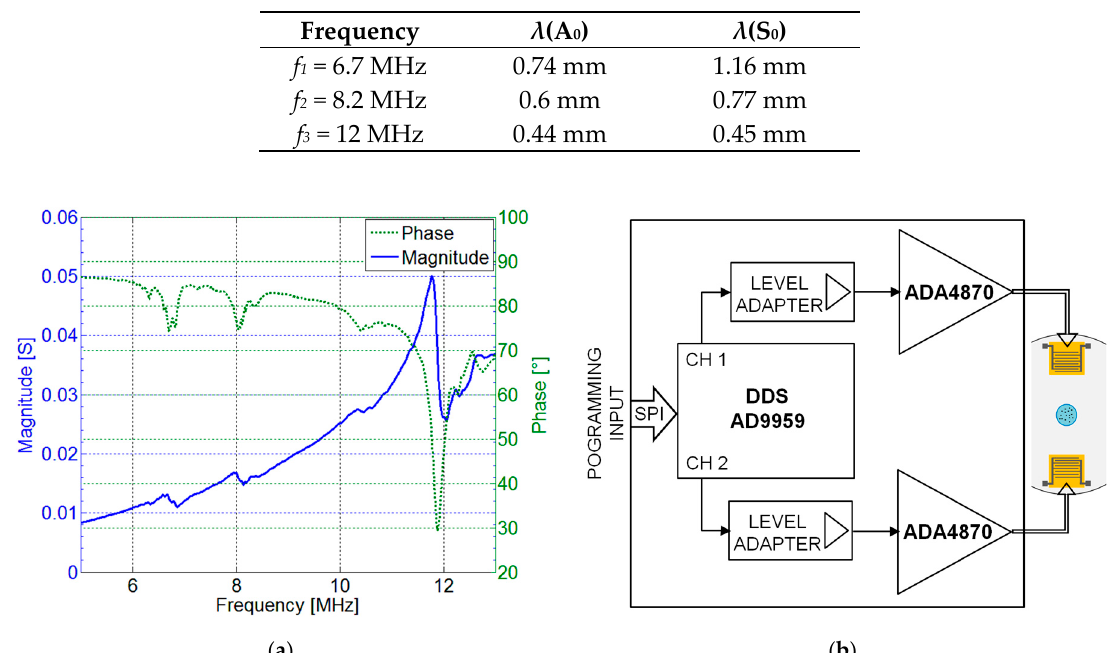
Figure 2. ( a ) Measured admittance (magnitude and phase) between the IDT electrodes as a function of frequency; ( b ) Block diagram of the tailored electronic interface designed to excite the actuators with sinusoidal signals with peak-to-peak amplitude and frequency of up to 20 V and 15 MHz,